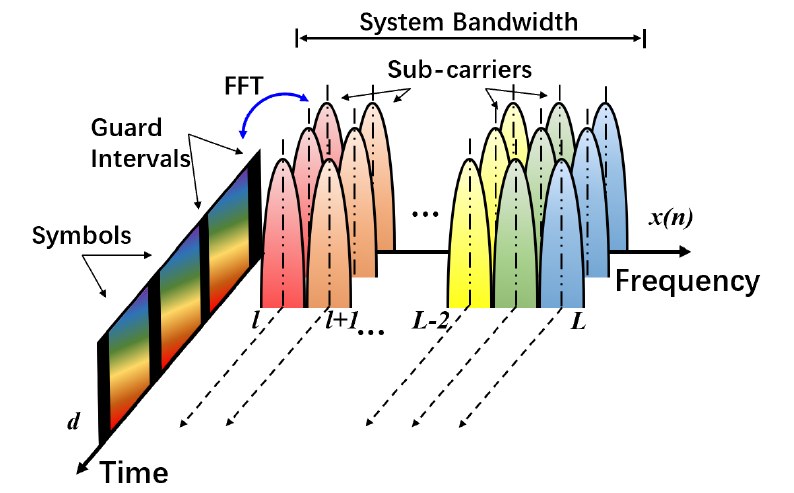
Figure 1. Time & frequency transformation of multi-carrier